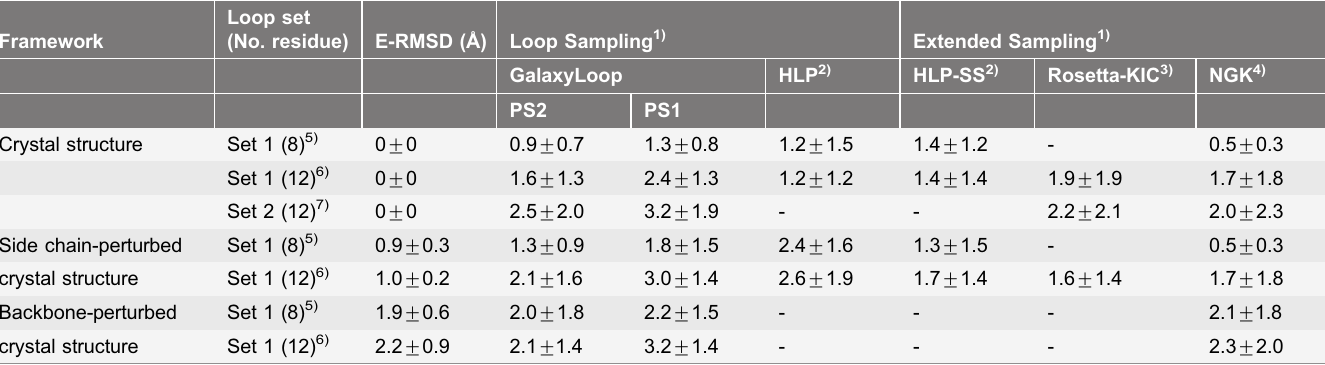
Table 1. Comparison of loop modeling results by the average RMSD of main chain atoms (N, C a , C, and O) of loops in angstroms (A˚ ) on test sets of varying environmental accuracies measured by E-RMSD.